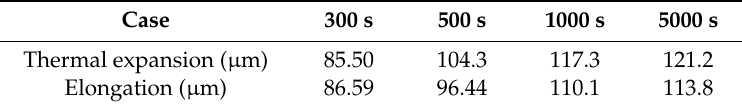
Table 1. Elongation verification of Inconel 718 with self-heating at 20 kHz.